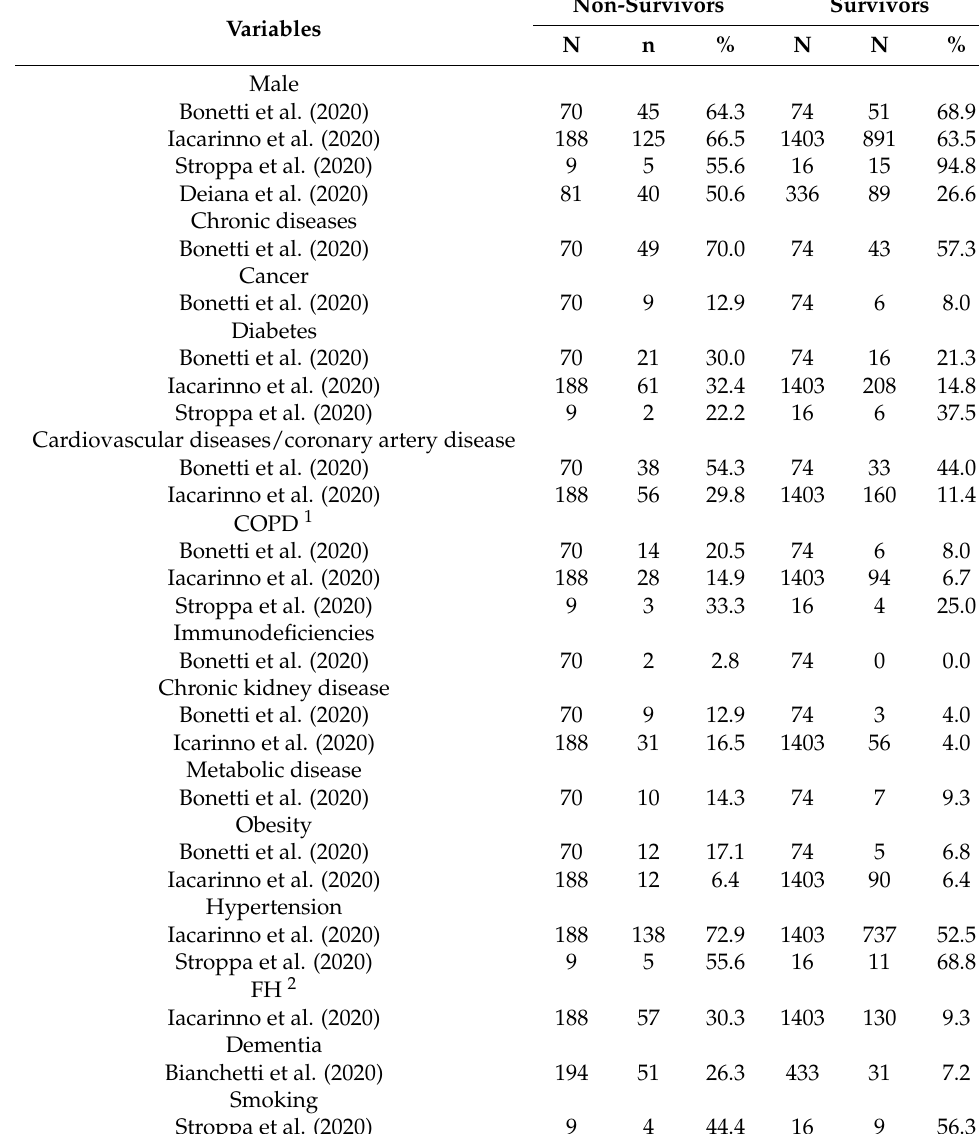
Table 4. Descriptive analysis of qualitative variables according to groups of survivors and